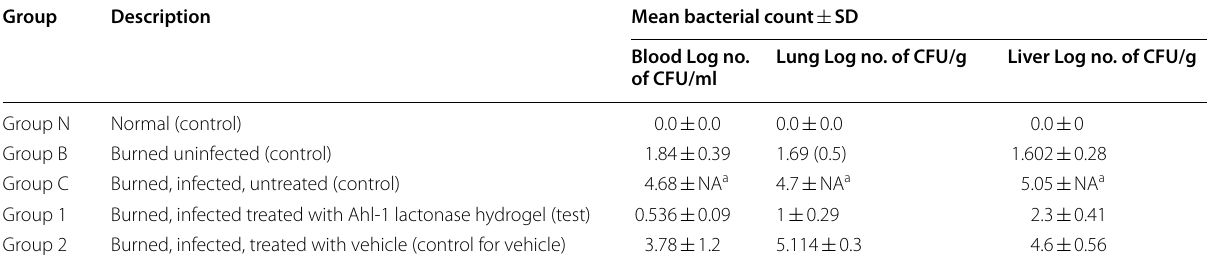
Table 4 Log viable count of P. aeruginosa in different organs of animals in different animal groups (P value <